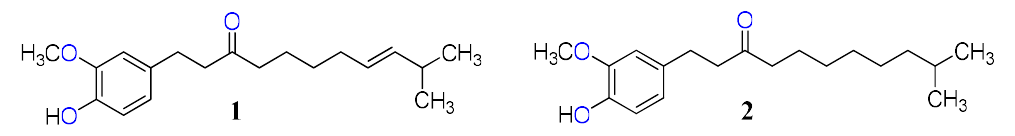
Figure 1. The structure of capsaicin ( 1 ) and dihydrocapsaicin ( 2 ). The capsaicinoids obtained from the fractionation step above were dissolved in 95% ethanol to a concentration of 100 mg/mL. The sample was subjected to the same flash single compound capsaicin (Table 2). Sample was injected into instrument for isolating. Fraction C (capsaicin) was collected. Fraction C was concentrated by evaporator. The concentrated solution was placed in a beaker and kept in a refrigerator (4 °C) for at least 24 h to allow the growth of crystals. The crystals were filtered through a 0.45 µ m mem- brane and air-dried in a fume hood to yield capsaicin. Table 2. The gradient regimen of mobile phase for separating capsaicin and capsaicinoids . Duration (min)